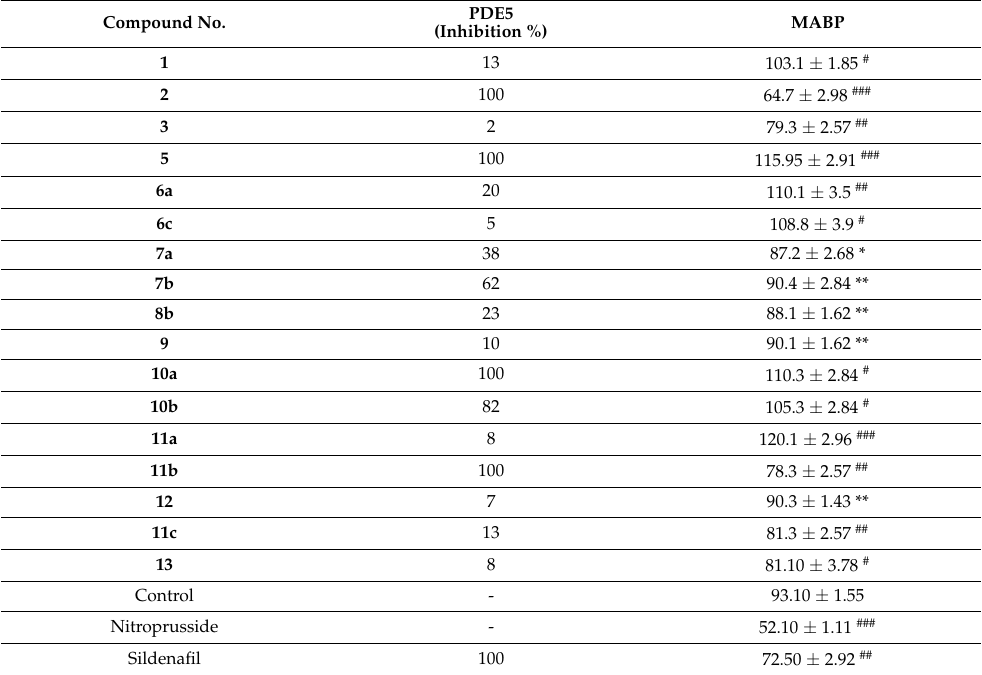
Table 1. Effect of tested compounds on PDE5 (10 4 nM) and MABP. Compound No.